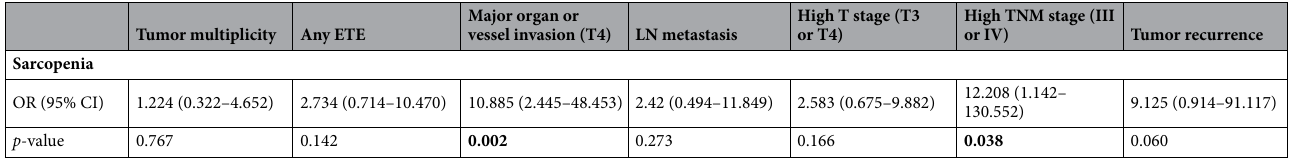
Table 3. Unadjusted logistic regression analyses between sarcopenia and clinicopathologic features. Significant values are in bold. OR odds ratio, CI confidence interval, ETE extrathyroidal extension, LN lymph node.